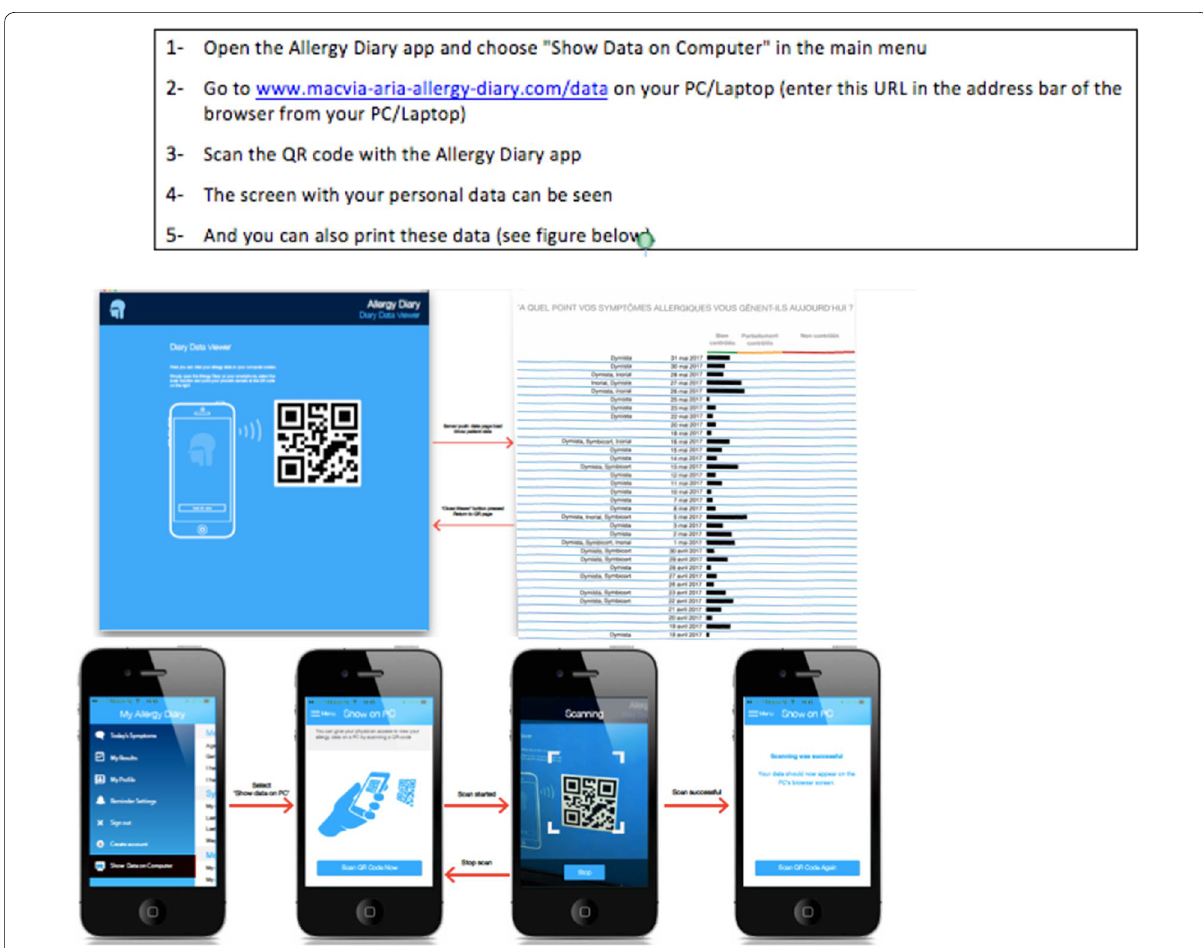
Fig. 3 Transfer of patient information on a computer and printed information (from Bousquet et al.